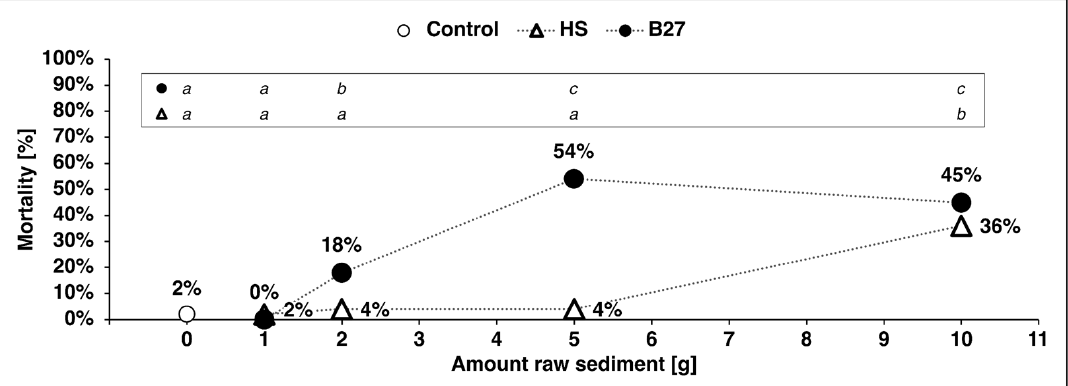
Figure 2. Mortality of the larvae exposed to sediment from the Halensee (HS) and B27 settling ponds in different concentrations after 96 h. Fisher’s exact test: (HS: df = 4, n = 250, p < 0.0001 *; B27: df = 4, n = 248, p < 0.0001 *) corrected for multiple comparisons using subsequent Bonferroni–Holm correction. Significant differences indicated by letters. Significant differences between the sediments not shown but described in text. Sample size: n = 10; number of larvae: control and all treatments n = 50. (Control : 10 g sand; 1 g : 1 g HS/B27 sediment, 9 g sand; 2 g : 2 g HS/B27 sediment, 8 g sand; 5 g: 5 g HS/B27 sediment, 5 g sand; 10 g : 10 g HS/B27 sediment (pure, no sand); all: 100 mL filtered water).